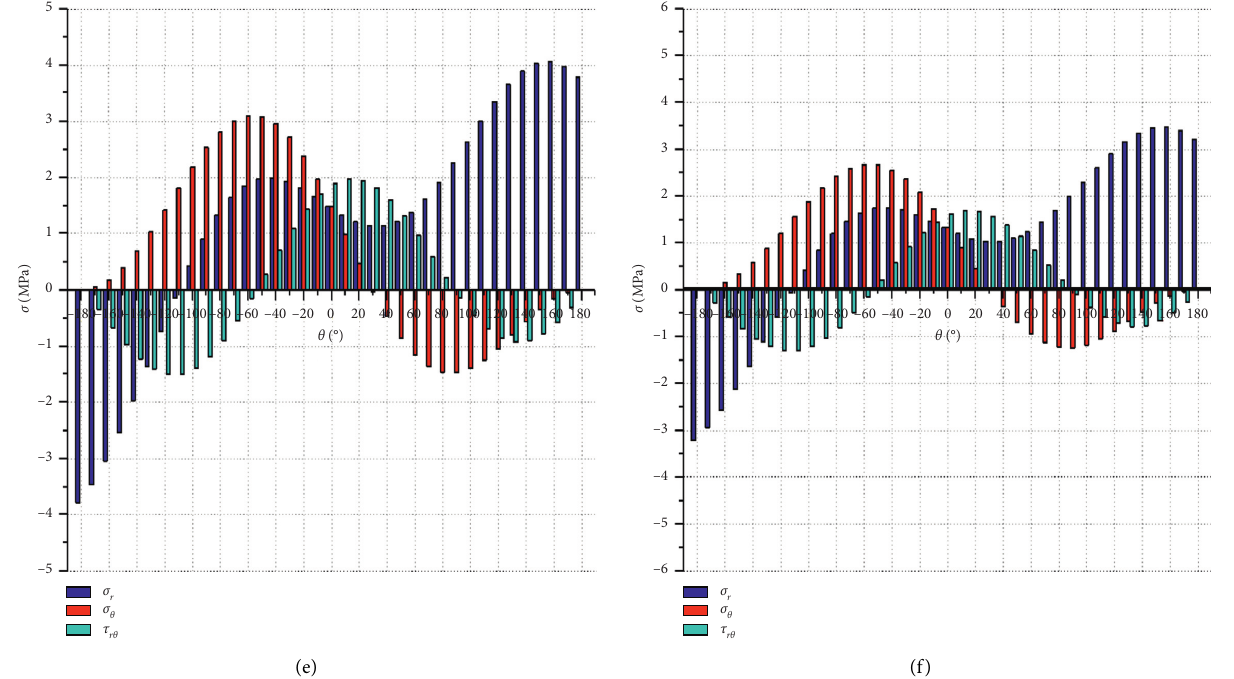
Figure 7: Variation curves of circumferential tensile stresses and shear stresses of the fissure specimens with different dip angles. (a) A - 1( σ 1max � 5.57MPa), (b) A -2 ( σ 1max � 5.9MPa), (c) B -1 ( σ 1max � 4.1MPa), (d) B -2 ( σ 1max � 5.42MPa), (e) C -1 ( σ 1max � 4.56 MPa), and (f) C -2 ( σ 1max �